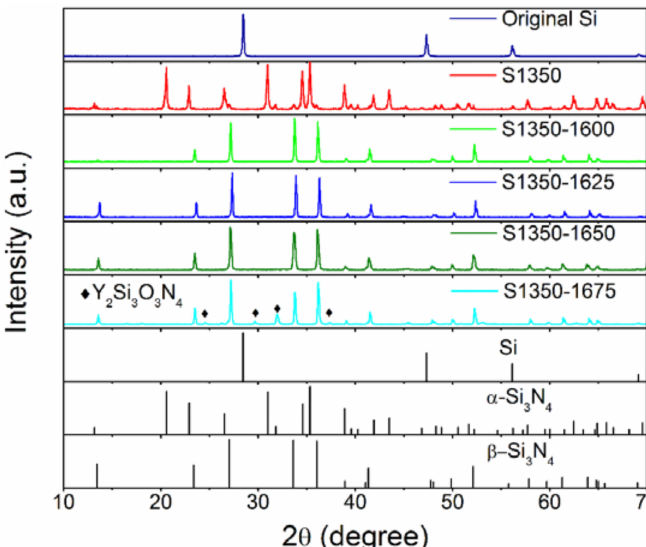
Figure 3. X-ray diffractograms of the produced tapes after sintering at 1600, 1625, 1650, and 1675 ◦ C along with the diffractograms of the original Si powder and the tape that was not subjected to sintering. The standard patterns of Si, α -Si 3 N 4 , and β -Si 3 N 4 are plotted at the bottom of the